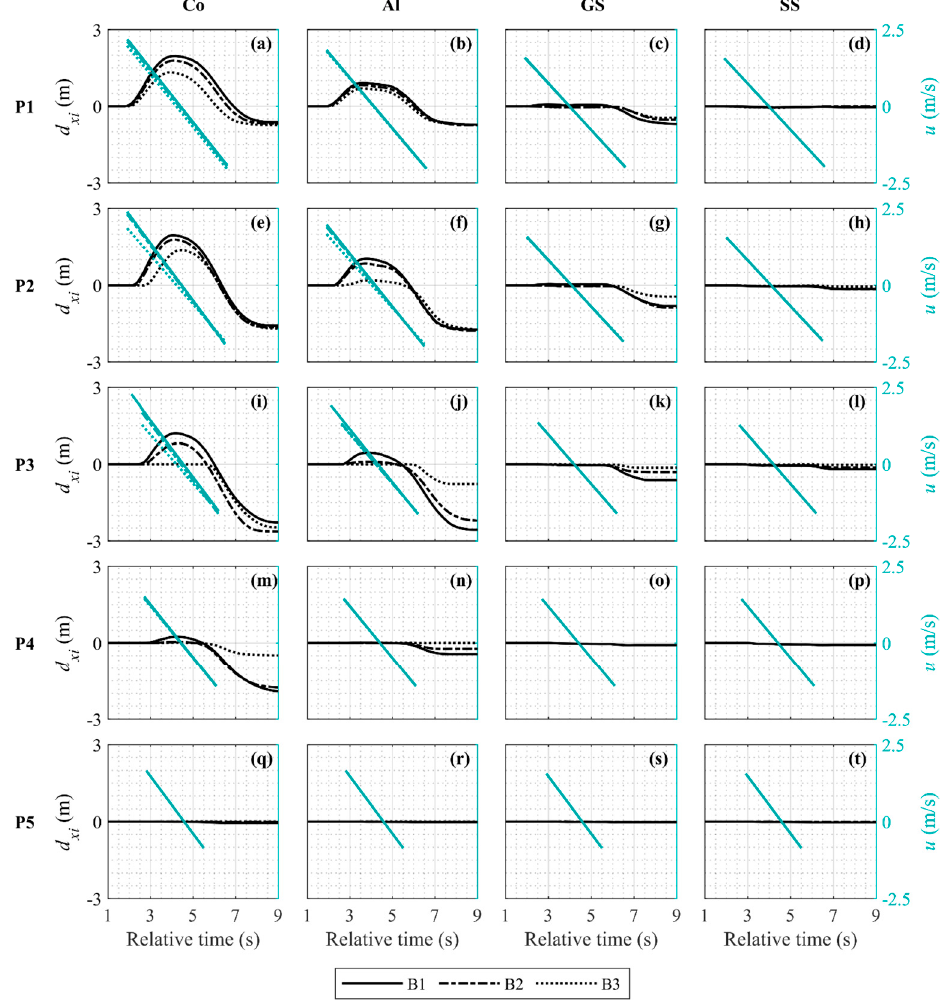
Figure 5. Averaged distance travelled and averaged interpolated cross-shore flow velocity for each scenario tested. ( a ) CoP1. ( b ) AlP1. ( c ) GSP1. ( d ) SSP1. ( e ) CoP2. ( f ) AlP2. ( g ) GSP2. ( h )